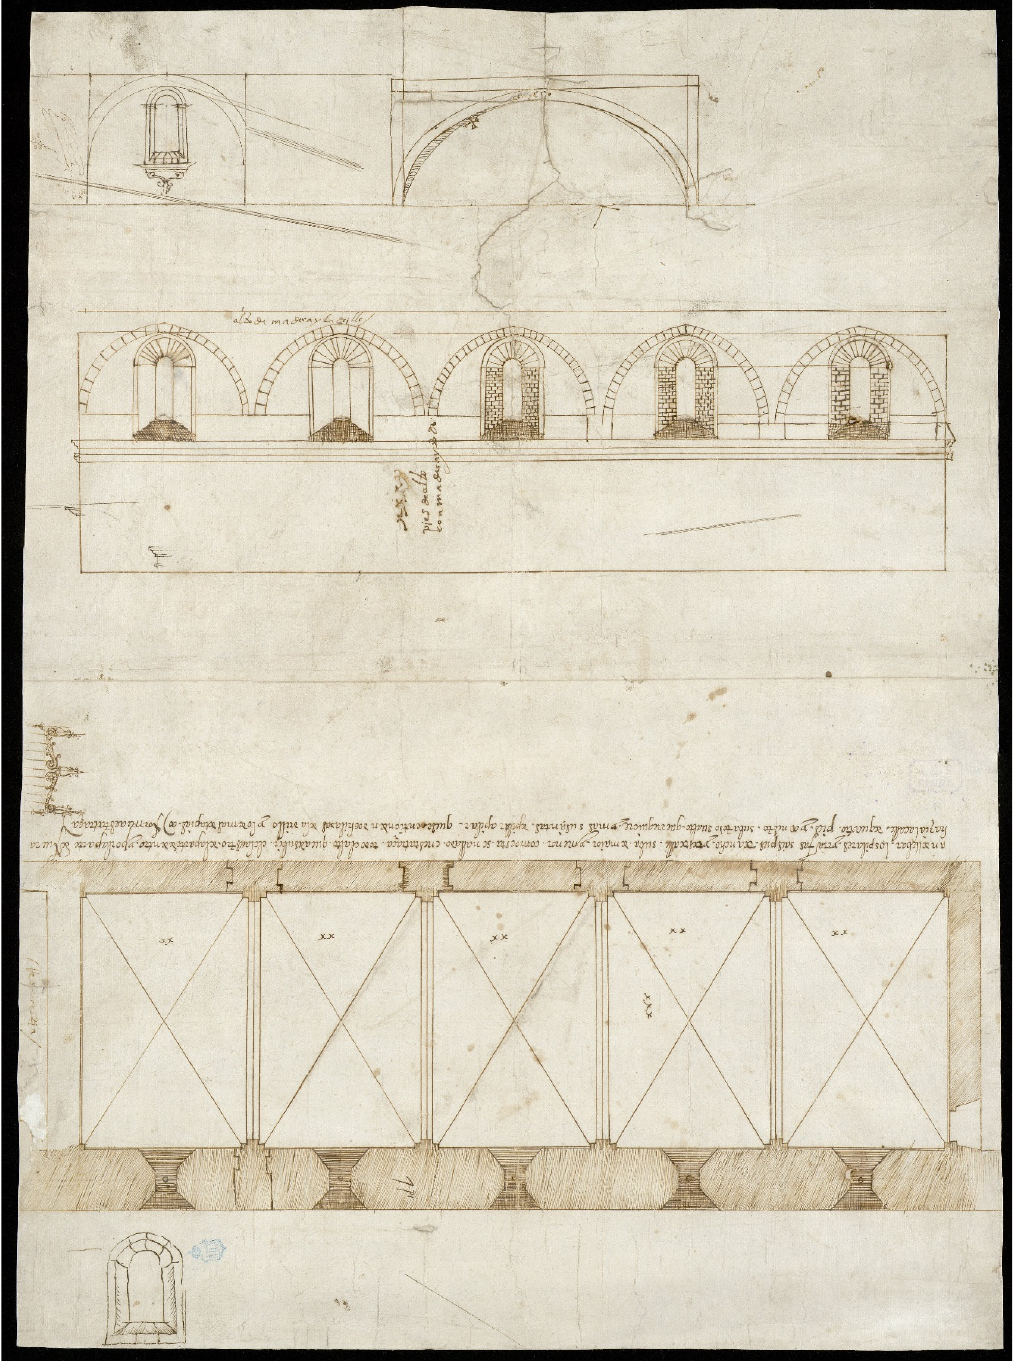
Figure 10. Project for the Cuarto de San Julián at the monastery of San Benito el Real in Valladolid (A.H.N., Clero, MPD, 129). © Archivo Histórico Nacional.